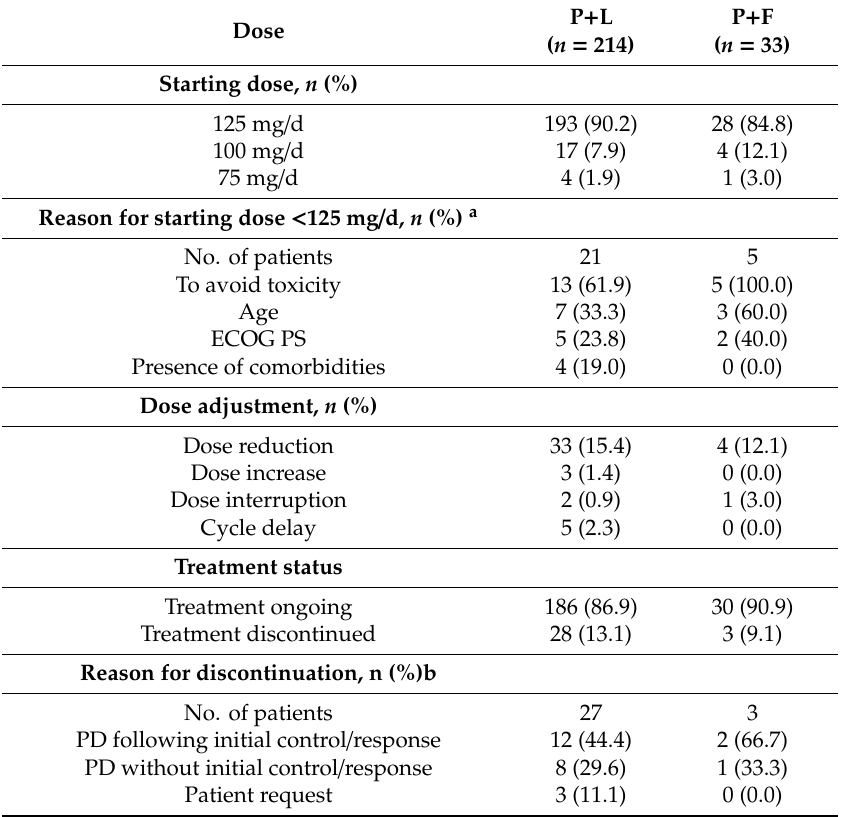
Table 3. Doses and adjustments in patients treated with P + L or P +